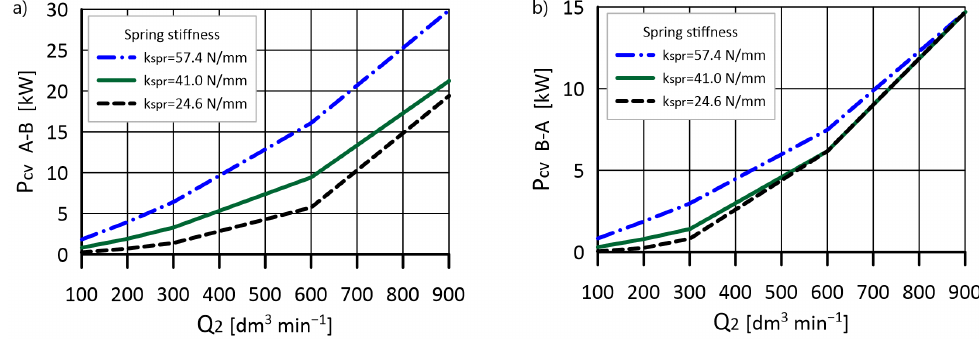
Figure 18. The power required to open the valve, flow direction: ( a ) A-B, ( b ) B-A.